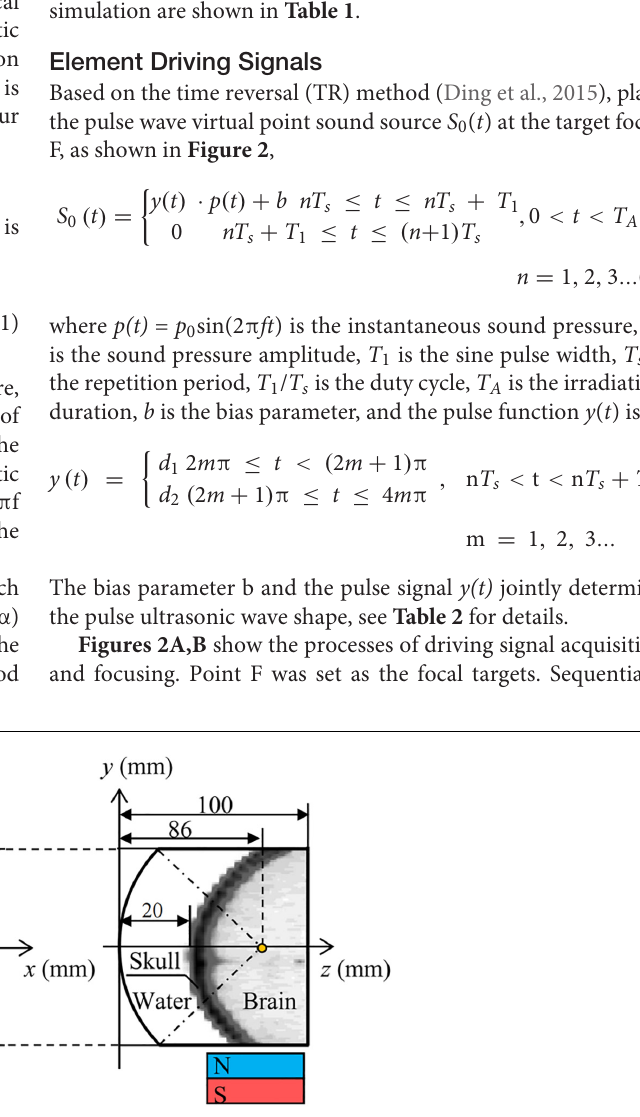
Frontiers in Neuroscience |